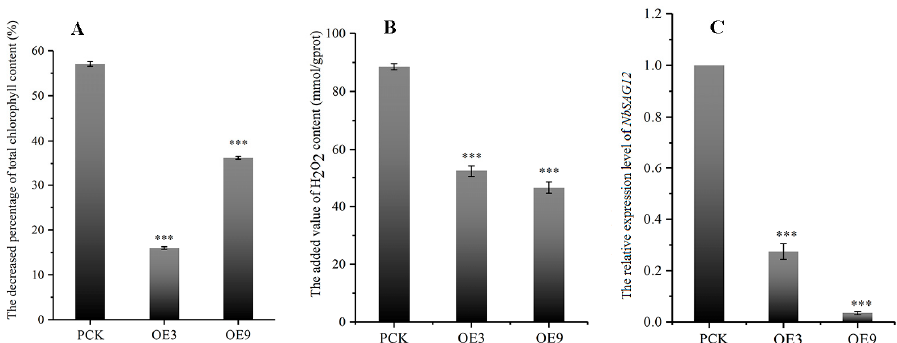
Figure 8. Determination of total chlorophyll and H 2 O 2 contents and the expression of NbSAG12 . ( A ) The decreased percentage of total chlorophyll content; ( B ) the increased values of H 2 O 2 content; ( C ) the expression levels of NbSAG12 in the transgenic lines.